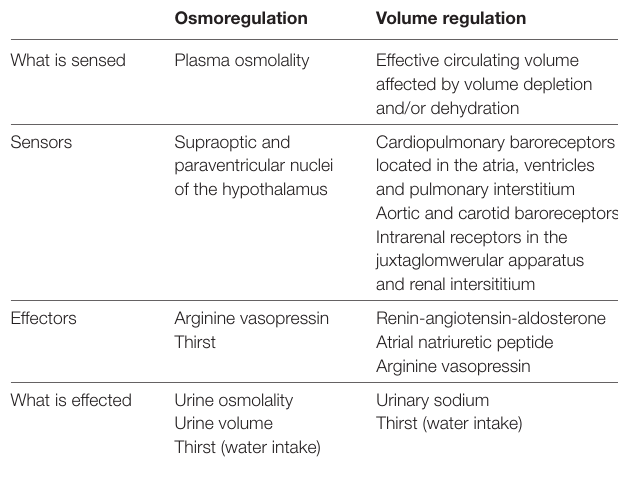
TABLe 4 | Osmoregulation and volume regulation of extracellular fluid volume (16, 34).